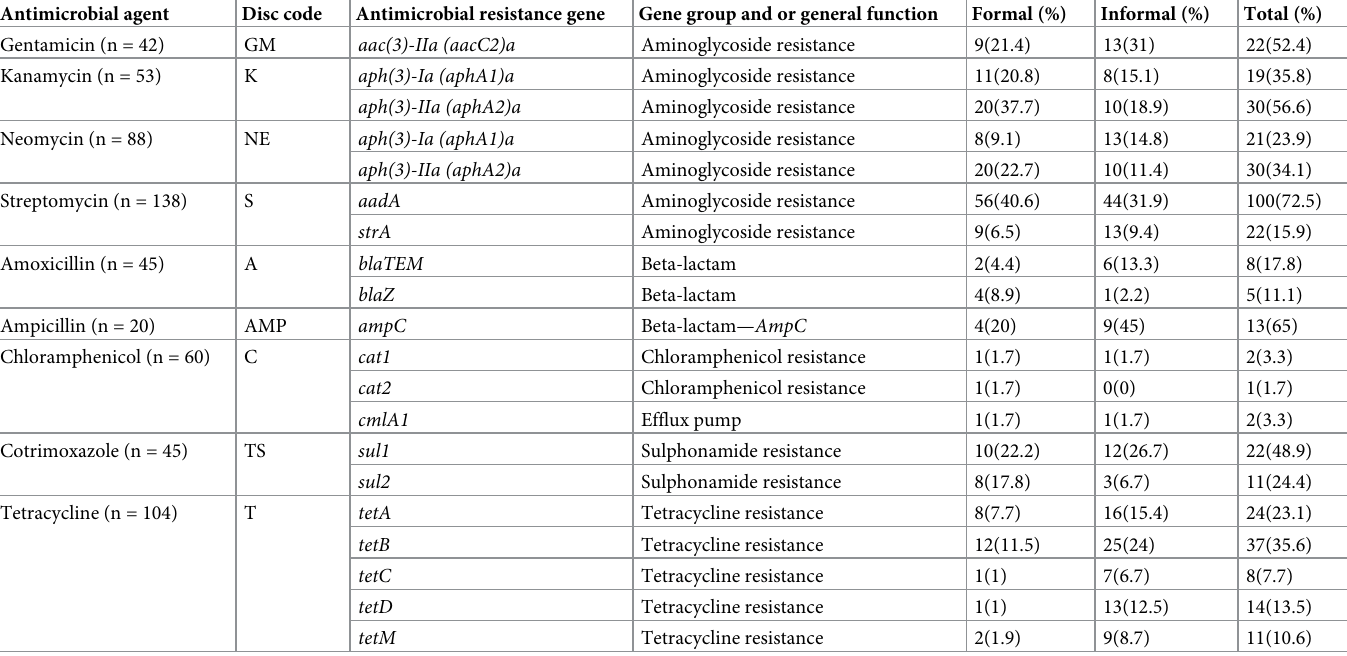
Table 4. Percentage and distributions of antimicrobial resistance determinants among E . coli from formal and informal sector. Antimicrobial